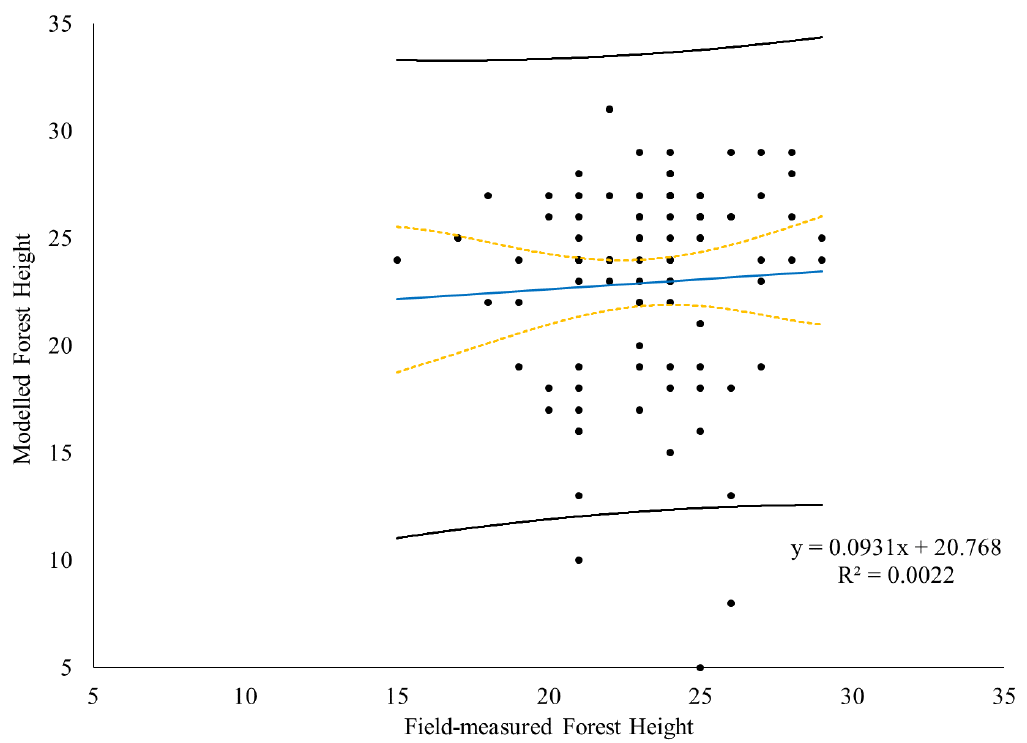
Figure 14. Linear regression with 95% confidence interval between field-measured and global forest canopy height map-based forest height.